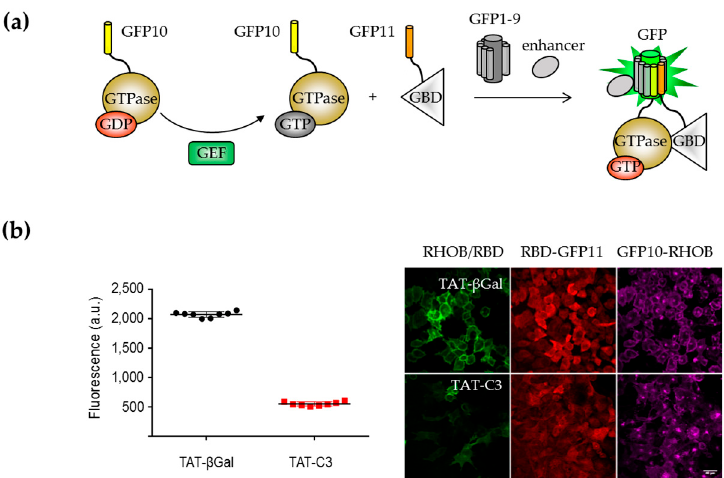
Figure 4. Analysis of the modulation of small GTPase activation with the tripartite split-GFP system. ( a ) When the GTPase is activated by guanine exchange factors (GEFs), the GTPase associates with the GTPase binding domain (GDP) of an effector protein. A VHH antibody that recognizes the full-length GFP is integrated in the cell line to enhance the fluorescence of reconstituted GFP. ( b ) Fluorescence analysis of RHOB activation reporter cells treated with 5 μ g/mL of TAT-C3 RHO inhibitor or with TAT- β Galactosidase control. n = 8 replicates of one experiment. Right image representative wide-field images showing the GFP fluorescence of RHO/RBD (rhotekin binding domain), and immunostaining with GFP10 antibody (GFP10-RHO) and GFP11 antibody (RBD-GFP11). Scale bar: 40 μ m.